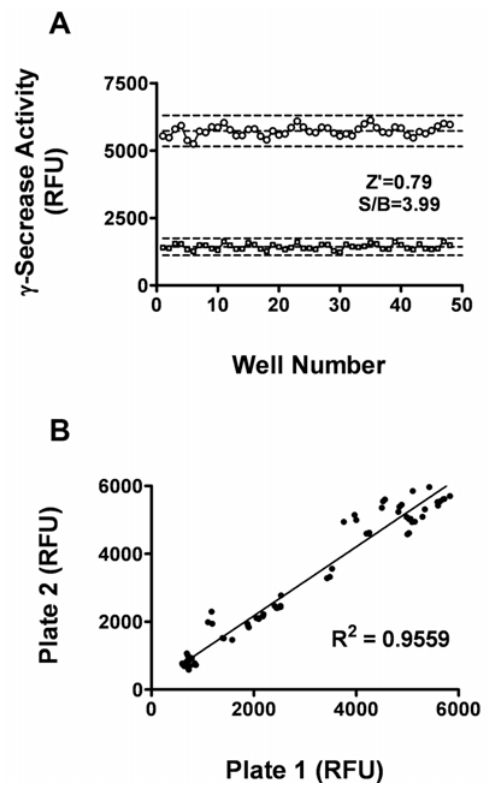
Figure 2. Assay Performance. (A) Z’ factor determination. At the optimized conditions (10  g membrane proteins, 6  M substrate, 5 h incubation time), 48 replicates of positive (wells treated with 1% DMSO) and negative signals (wells treated with 1  M L685,458) were studied. Dashed lines indicate means ± 3 SD of 48 data points. (B) Reproducibility. The corresponding wells from two different 96-well plates were inhibited with same concentration of L685,458. The reproducibility of data from duplicate plates was investigated with linear repression